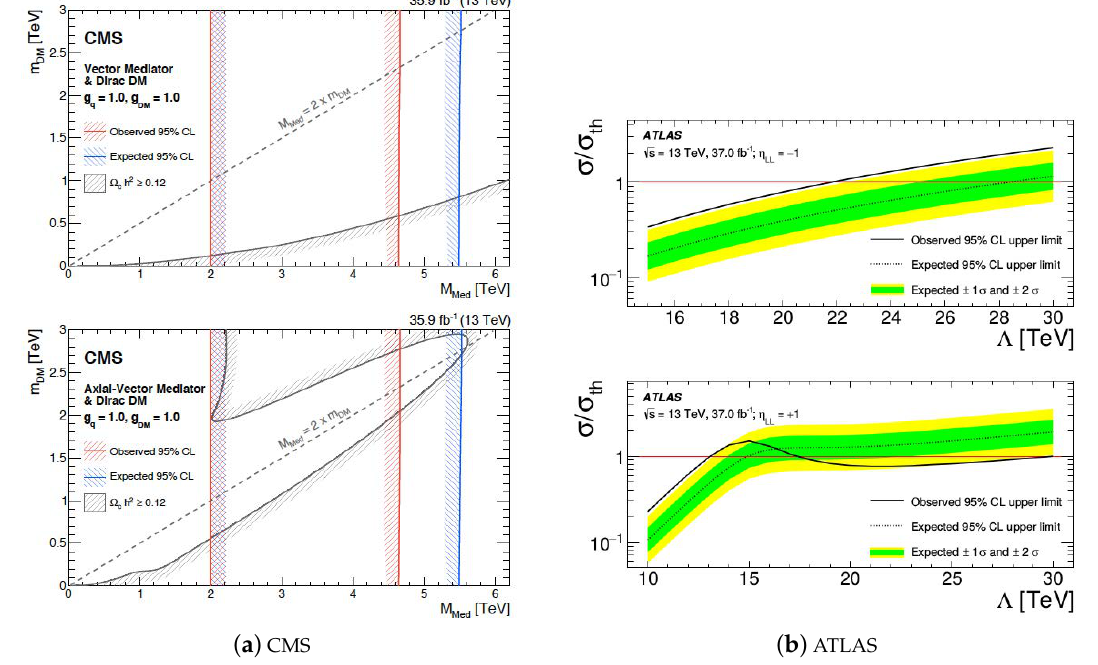
Figure 13. Results for the CMS [25] ( a ) and the ATLAS [23] ( b ) di-jet χ searches. CMS results assume a coupling g q between quarks and mediator of one, while ATLAS considers effective interactions characterized by a single energy scale Λ